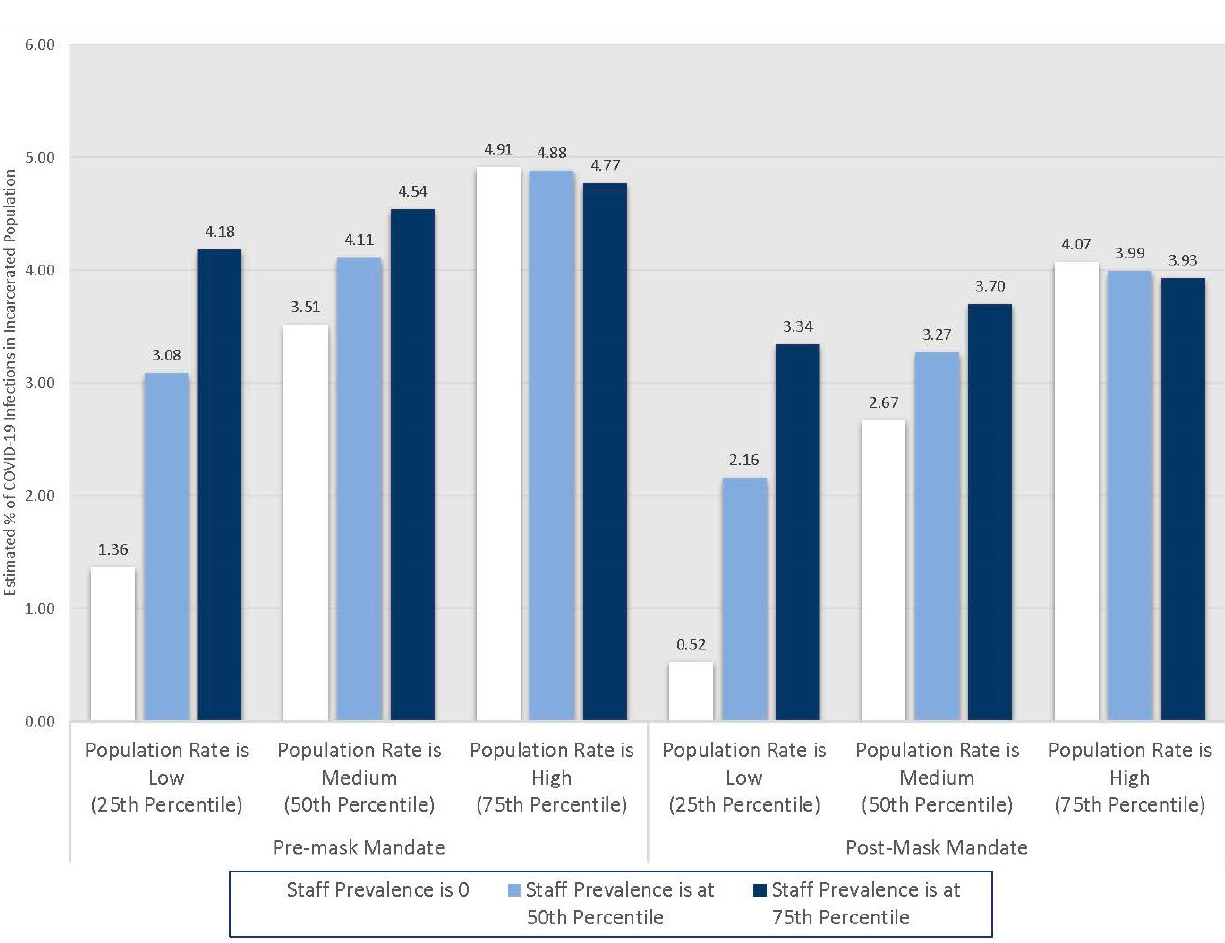
Figure 2. Point estimates for active cases of COVID-19 among incarcerated persons at the twenty-fifth, fiftieth, and seventy-fifth percentiles of the lagged and logged staff prevalence and county incidence of COVID-19 for pre- and post-mask mandate periods.